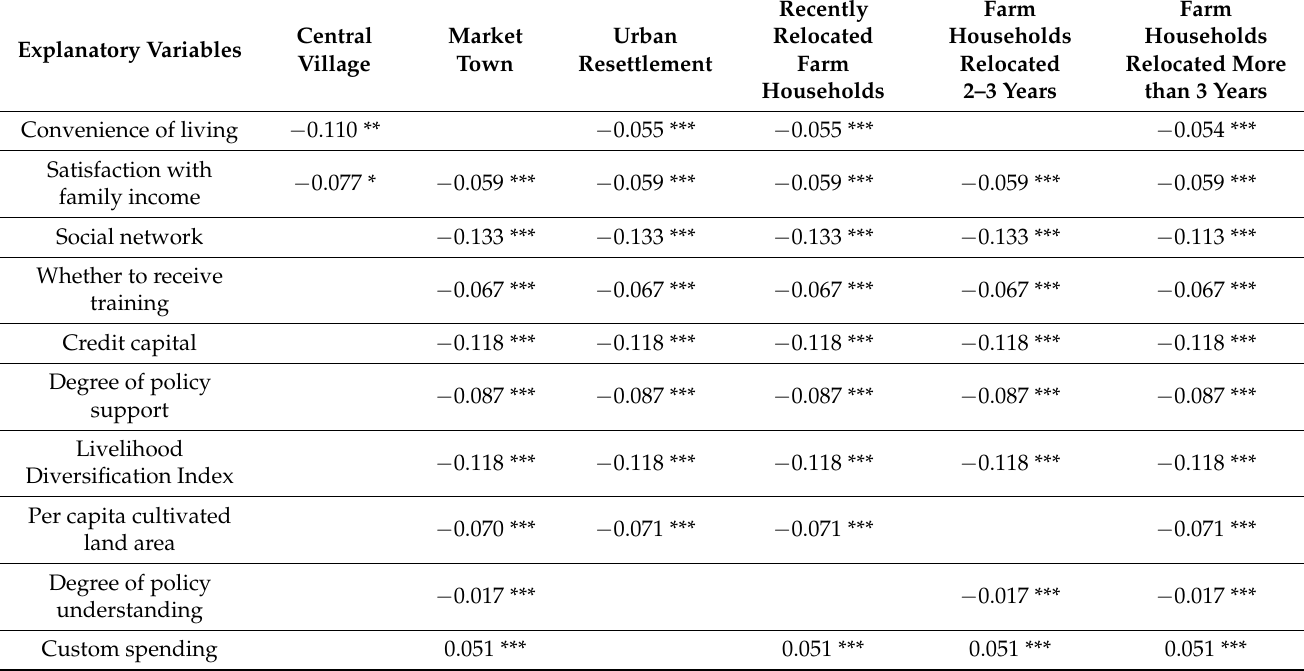
Table 7. Evaluation results of influencing factors of livelihood vulnerability in different resettlement methods and different relocation